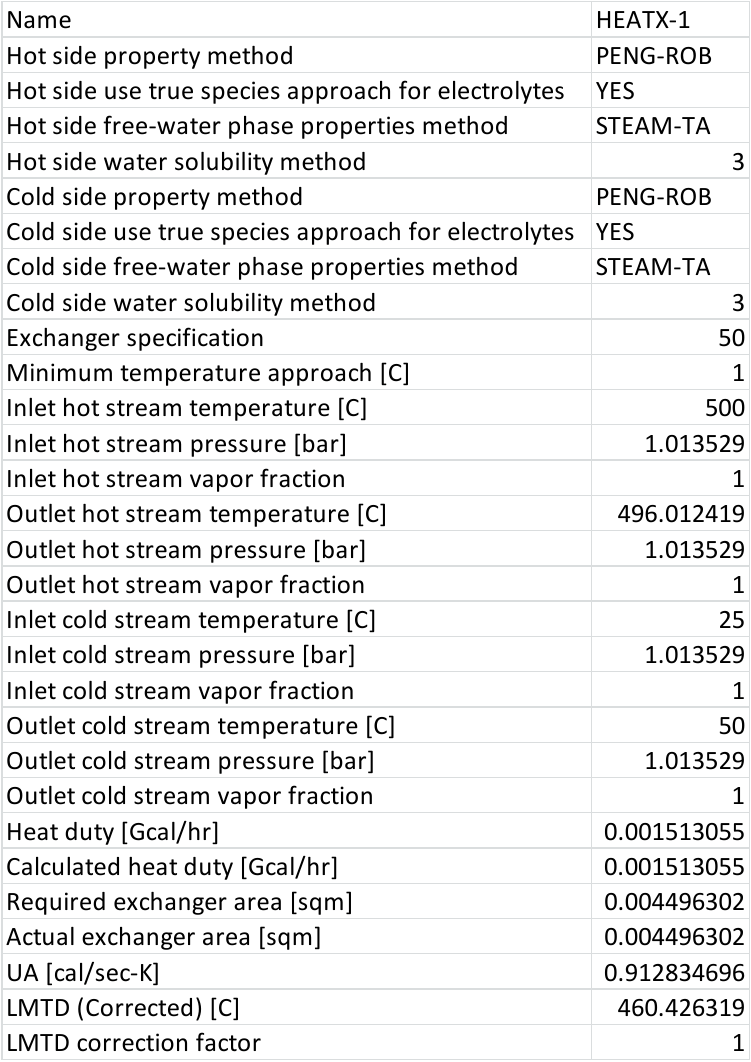
Figure A3. Pyrolysis heat exchanger results.